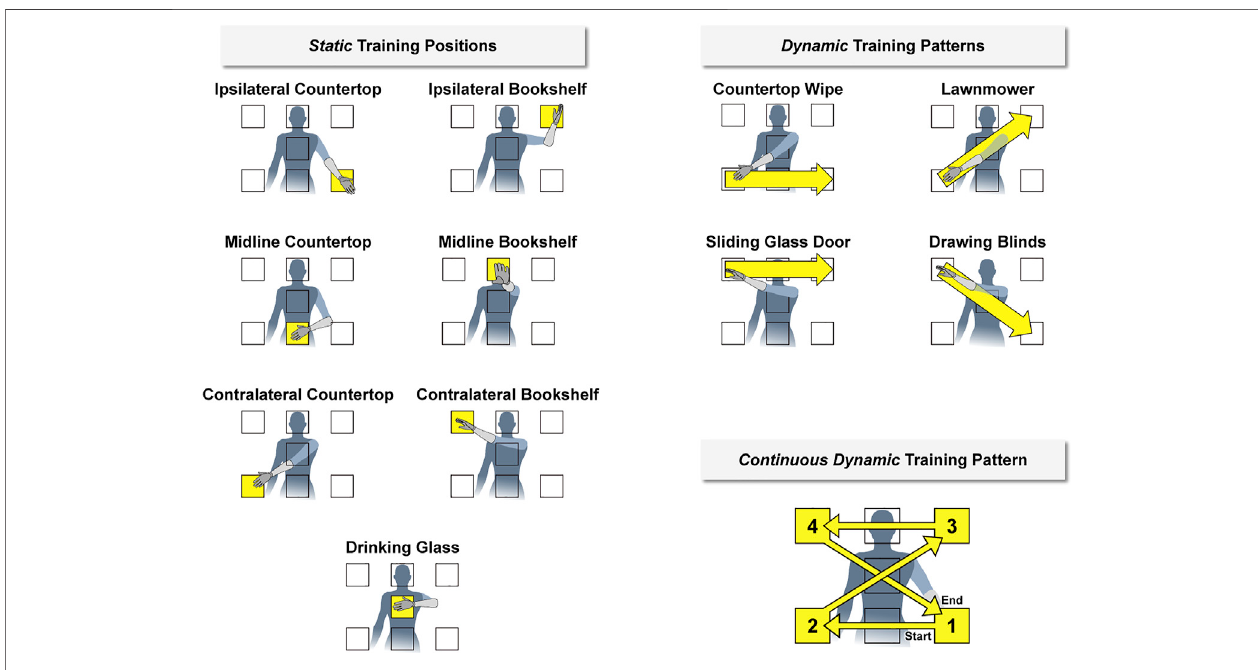
FIGURE2| Weimposeddiscretearmpositionsandmovementpatternsduringclassi fi ertraining(shownhererelativetotheleftarm).Duringthe static condition,the participant held her hand for 5 seconds within seven different positions designed to cover a majority of the reachable workspace. During the dynamic condition, the participant moved her hand for 5 seconds between these positions in four different movement patterns. We also considered a continuous dynamic condition, in which the participant moved her hand throughout all positions during a single 20-sec movement pattern. The names of each position and pattern were based on a functional activity for that arm con fi guration. Corresponding positions and movement patterns were also established relative to the right arm (i.e., fl ipped